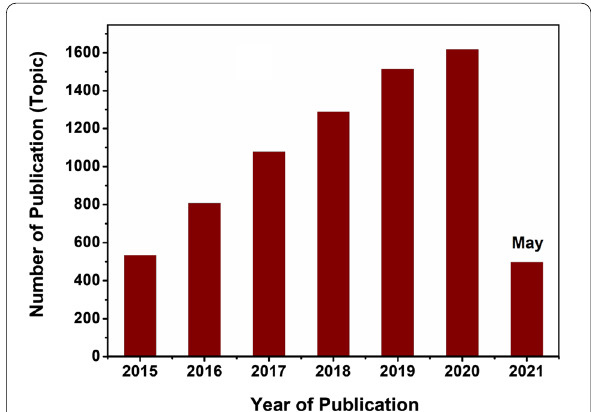
Fig. 1 Dynamics of number of published articles for “ 2D semiconductors ” based on Web of Knowledge